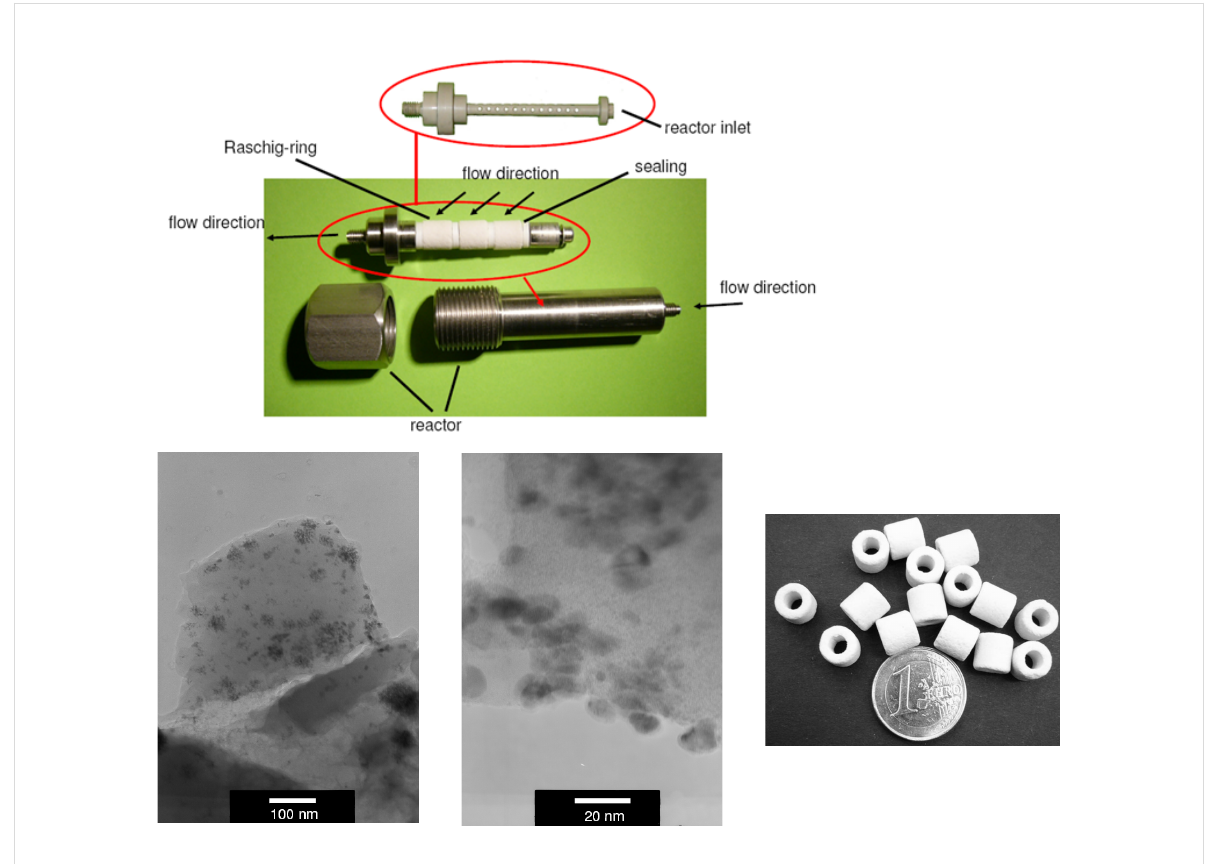
Figure 1: Top: Reactor (1–2 mL dead volume) with functionalized Raschig-rings; bottom: TEM-micrographs of Pd(0) nanoparticles on optimized polyionic gel (left and central) and Raschig-rings (right).